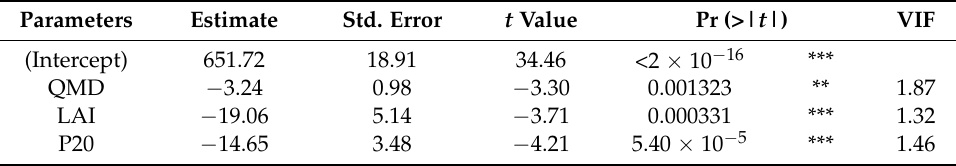
Table 2. Parameter estimates and variance inflation factor of the parametric multiple regression model (model 1) fit using some selected predictor variables estimated from airbore LiDAR